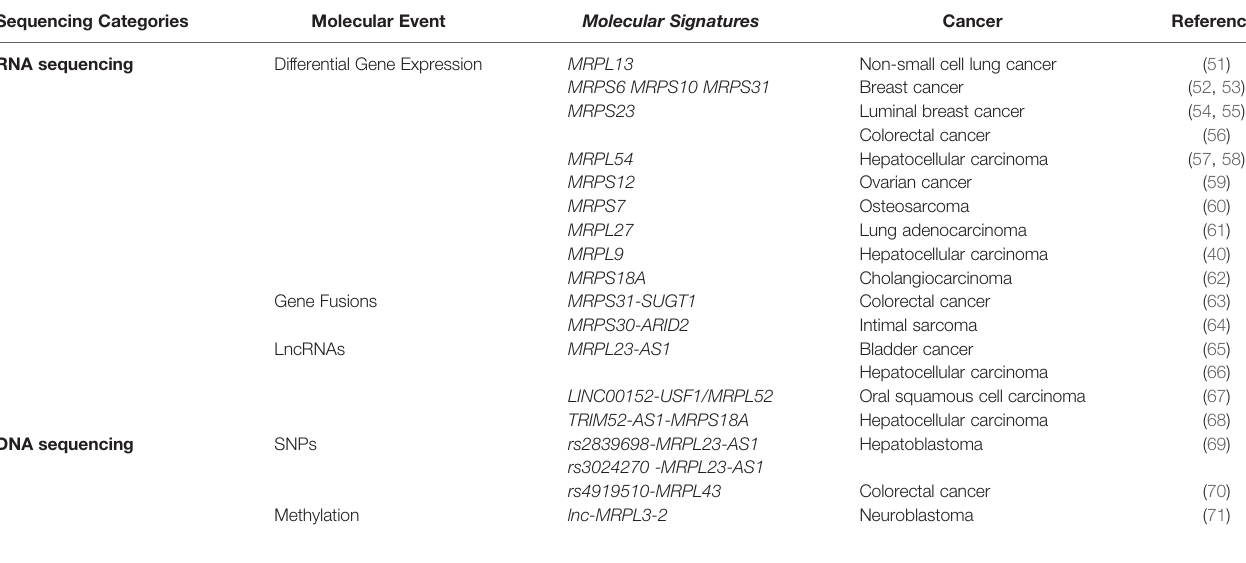
TABLE 1 | Association between mitochondrial ribosomal genes and cancer revealed by high-throughput sequencing. Sequencing